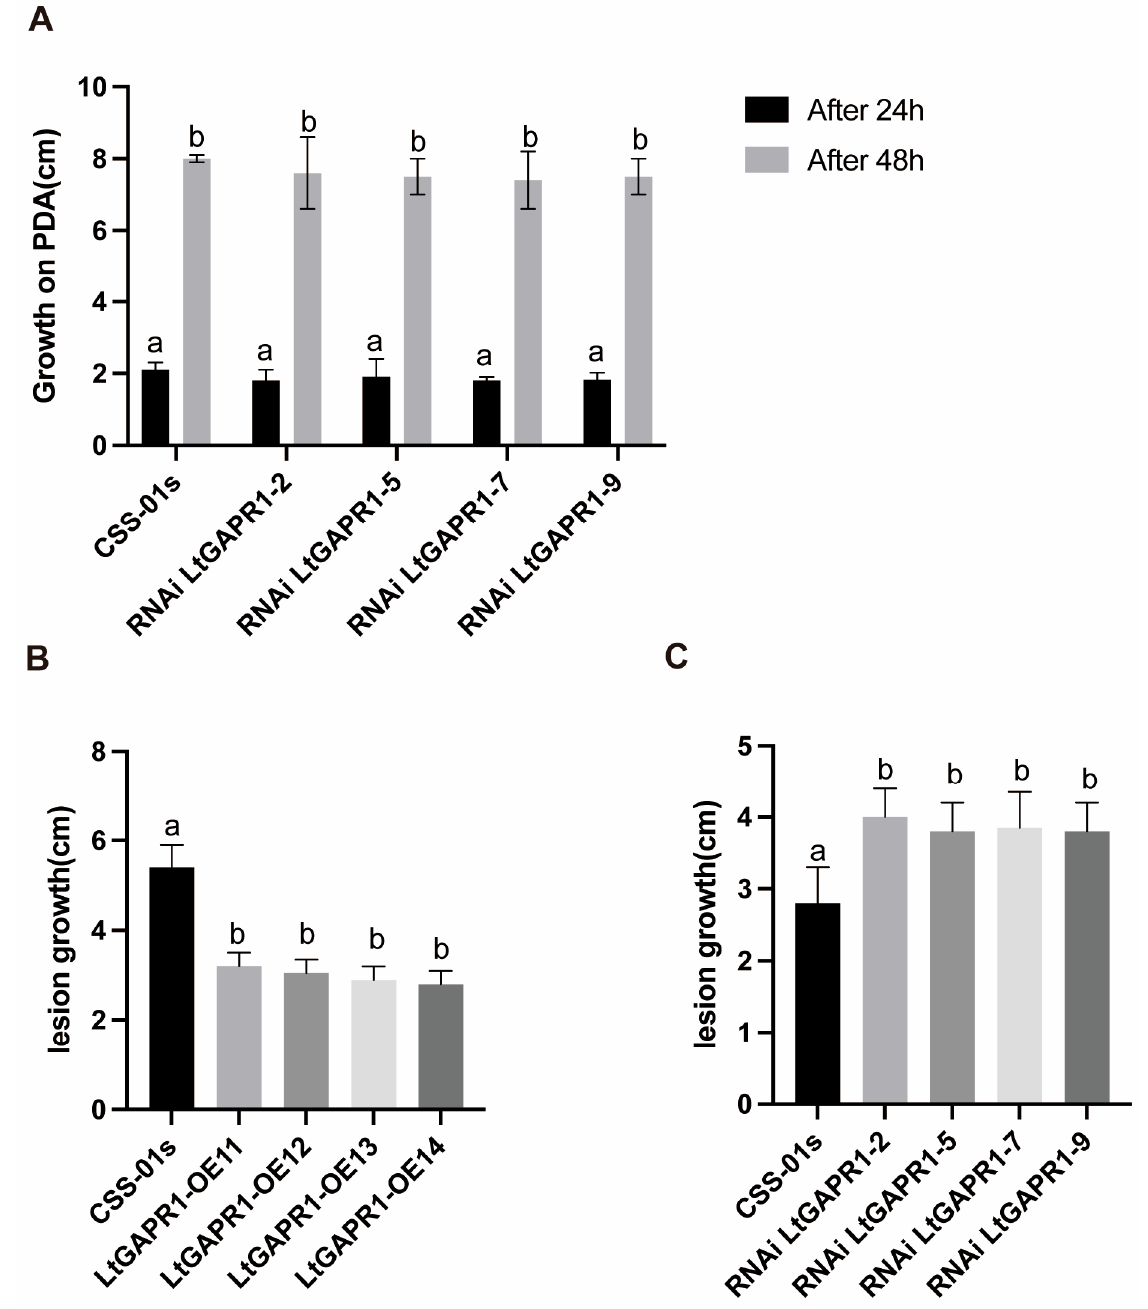
Figure 2. LtGAPR1 negatively regulated the virulence of L. theobromae but did not affect its vegetative growth. ( A ) Vegetative growth of the wild-type L. theobromae strain, CSS-01s, and several RNAi-LtGAPR1 strains on PDA at 24 and 48 h. ( B ) Statistical analysis of lesion length caused by overexpressed LtGAPR1 transformants. One-year-old grapevine shoots were inoculated using mycelial plugs (5 mm in diameter) and kept in a chamber under constant humidity and temperature. The inoculated grapevines were photographed at 3 days post inoculation (dpi). Bar = 1 cm. ( C ) Statistical analysis of lesion length caused by the silenced transformants of LtGAPR1. The means and standard errors were calculated from five replicates. One-way ANOVA was performed for statistical analysis. Isolates that do not share the same letter (a, b) exhibit a significant difference among the